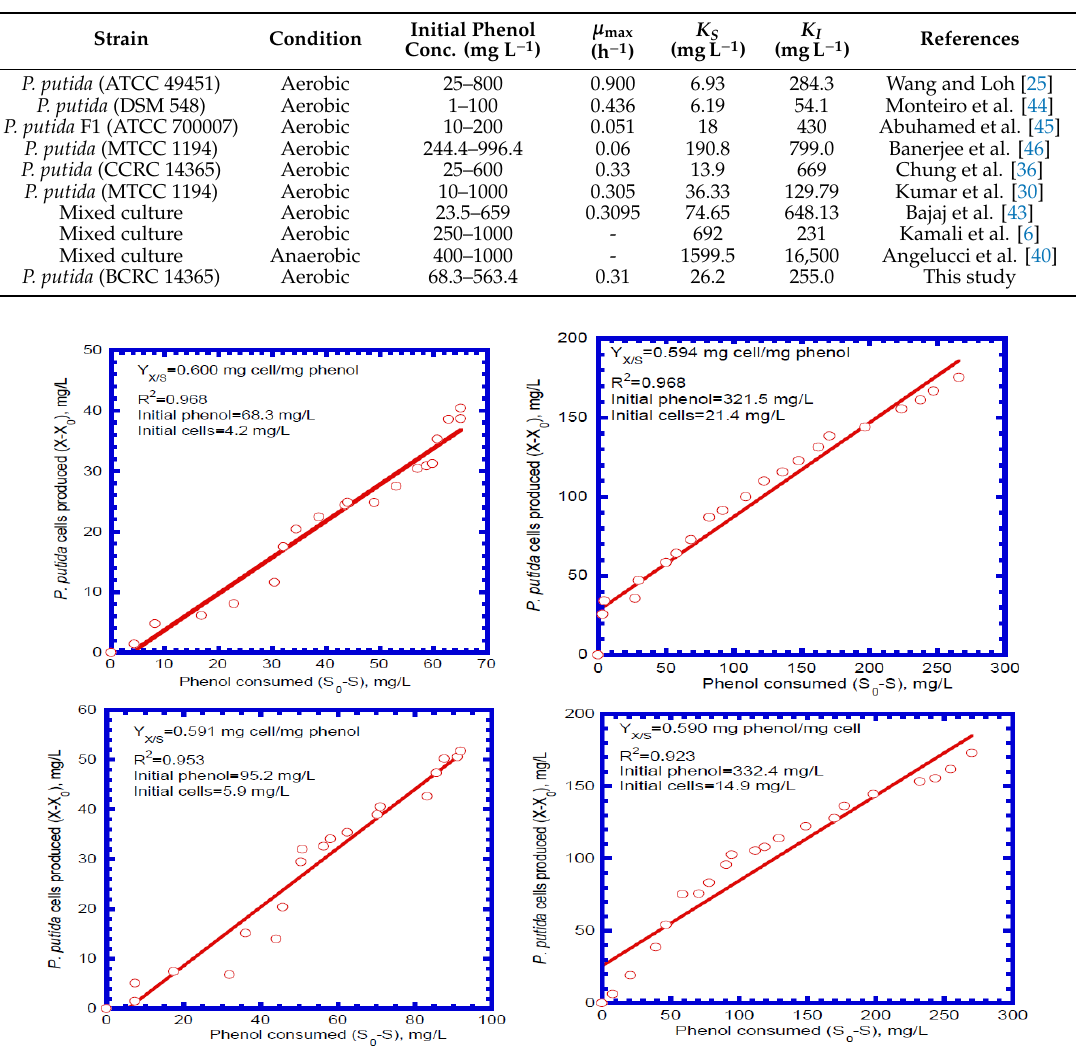
Figure 9. Plot to calculate the yield coefficient (Y) for P. putida cells at various initial phenol and cell concentrations. The experimental data of the endogenous region was plotted as natural logarithm-ln (residual cell concentration) against time to assess the slope that provides the decay coefficient ( b ). Figure 10 shows the seven batch kinetic tests used to evaluate the decay coefficient of P. putida cells. The decay